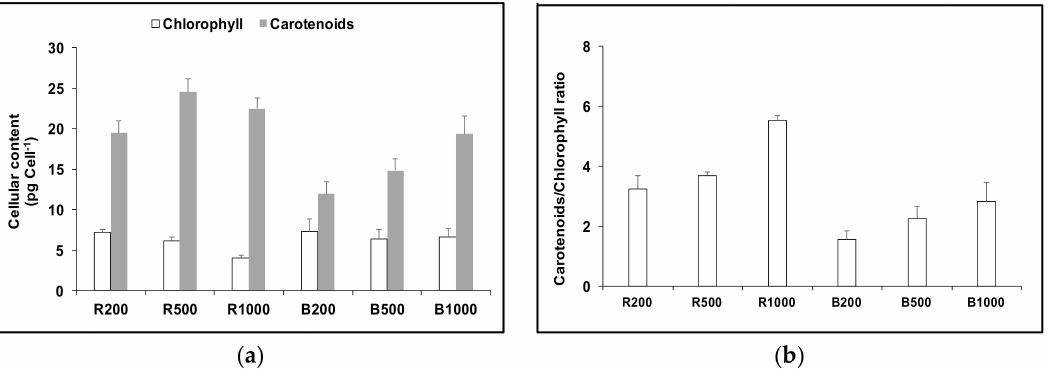
Figure 4. Cellular content of total carotenoids and total chlorophyll ( a ) and carotenoids / chlorophyll ratio ( b ) in D. salina CCAP19 / 41 grown under continuous red (R200; R500; R1000) or blue (B200; B500; B1000) LED light at three di ff erent light intensities of 200, 500 and 1000 µ mol m − 2 s − 1 for 48 h. Each culture condition was set up at least in triplicate.